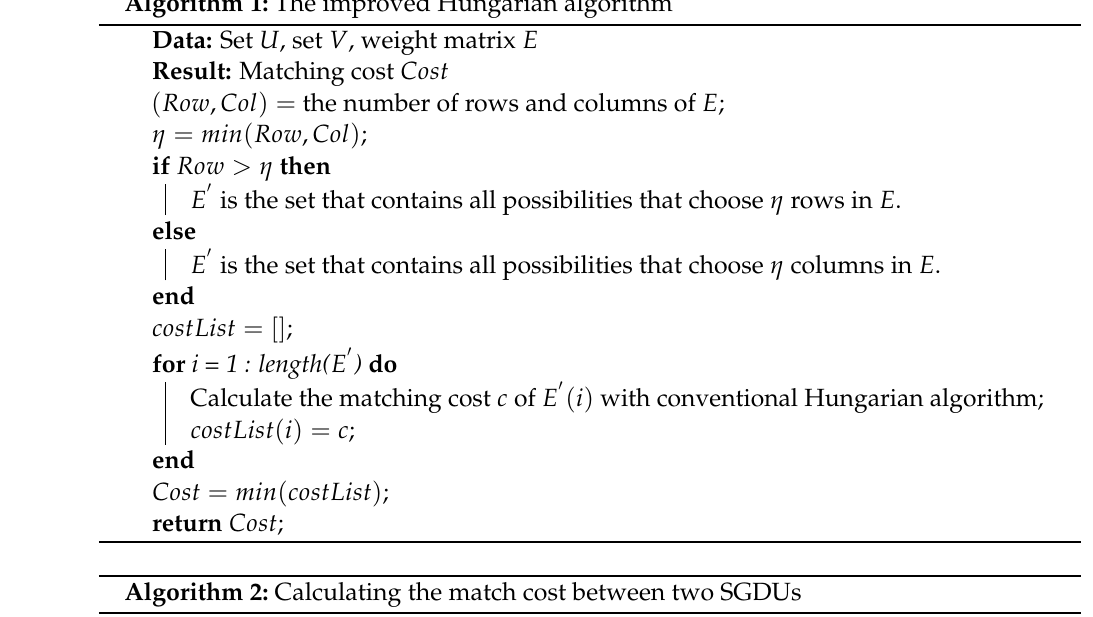
Algorithm 1: The improved Hungarian algorithm